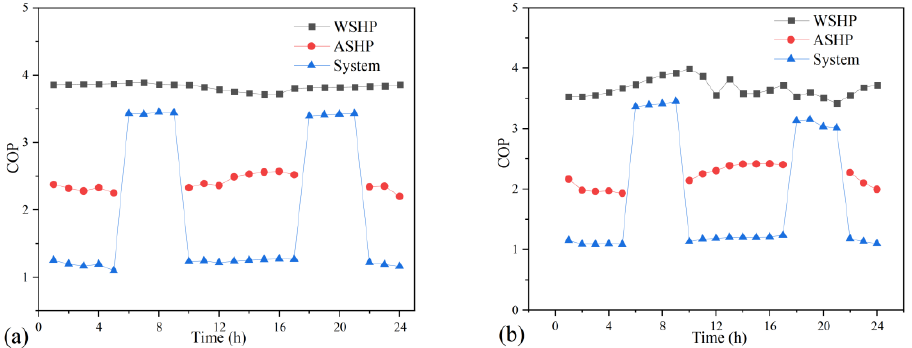
Figure 11. COP s of the ASHP, the WSHP, and the system: ( a ) simulated, ( b ) tested.